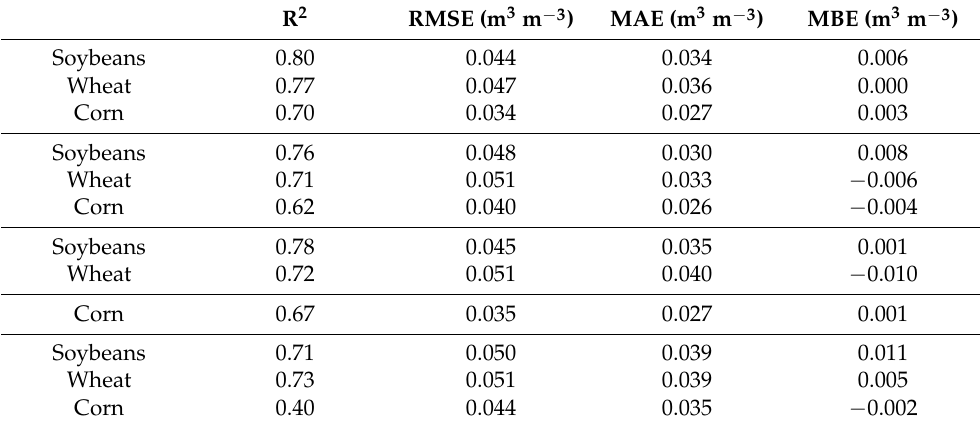
Table 8. Accuracy statistics for estimating soil moisture using a neural network algorithm for soybean, wheat, and corn canopies, and different feature selection